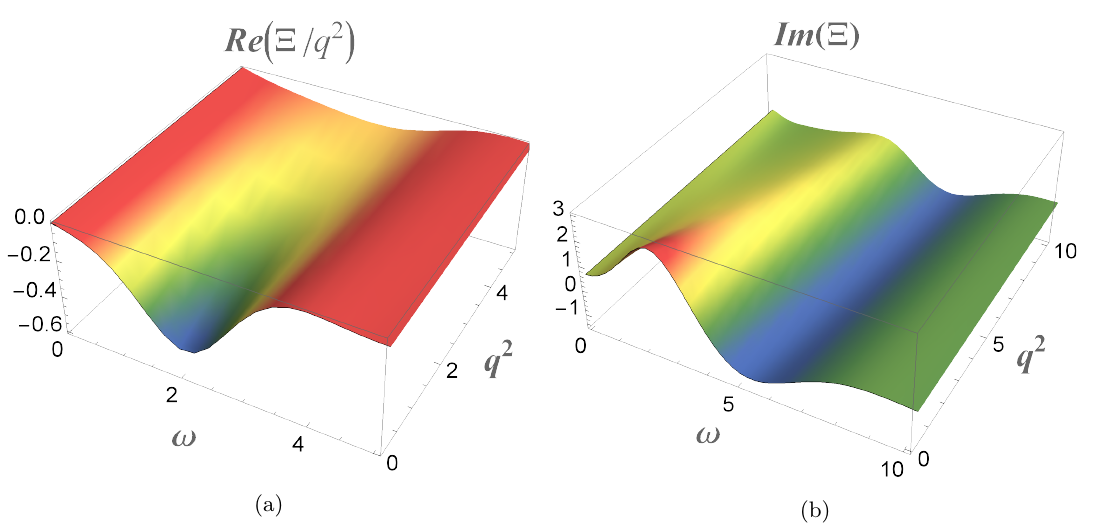
Figure 5 . The ω -, q -dependence of the coefficients (a) Re (Ξ( ω, q 2 )) (b) Im (Ξ( ω, q 2 ))